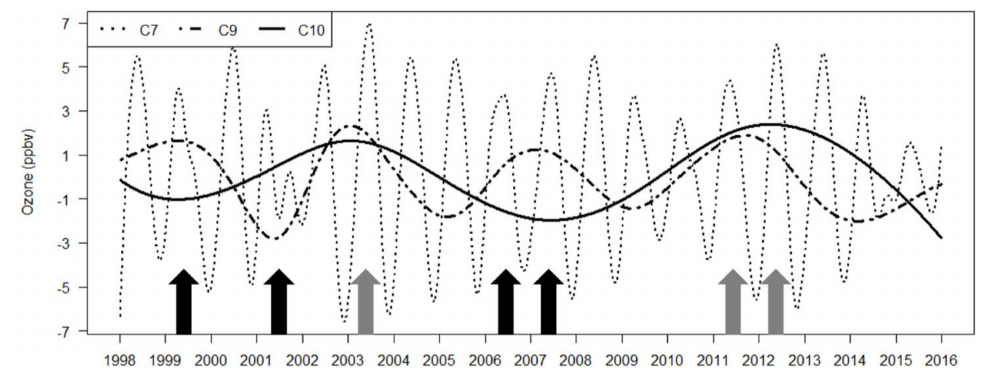
Figure 7. The various effects of C9 and C10 on C7, the seasonal component, depending on the cycle phase. Black arrows indicate that C9 and C10 are out-of-phase; grey arrows indicate that the components are